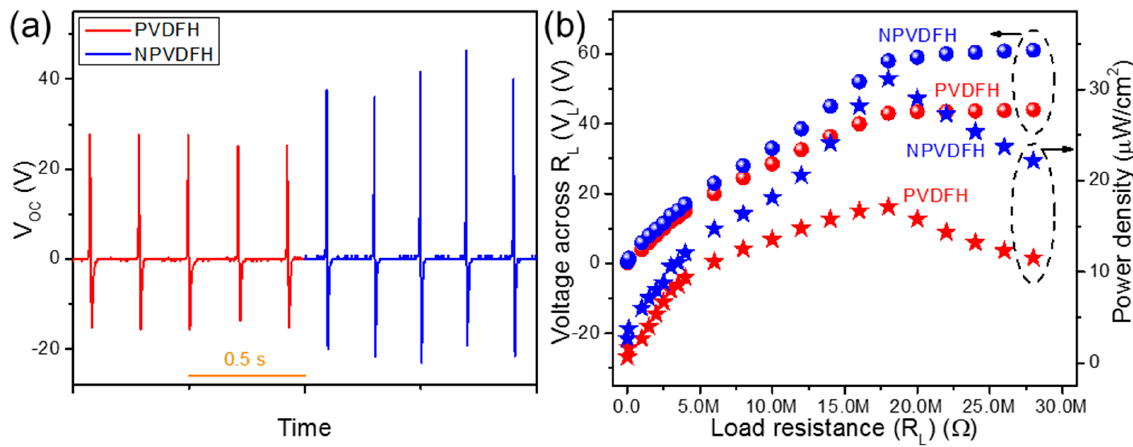
Figure 10. ( a ) Output V OC and ( b ) R L -dependent V L and power density of the fabricated PVDFH and NPVDFH devices. Table 4. Comparison of output power density ( P ), load voltage ( V L ), and load current ( I L ) of the fabricated NPVDFH device (HNG) with some other similar kinds of devices reported earlier.